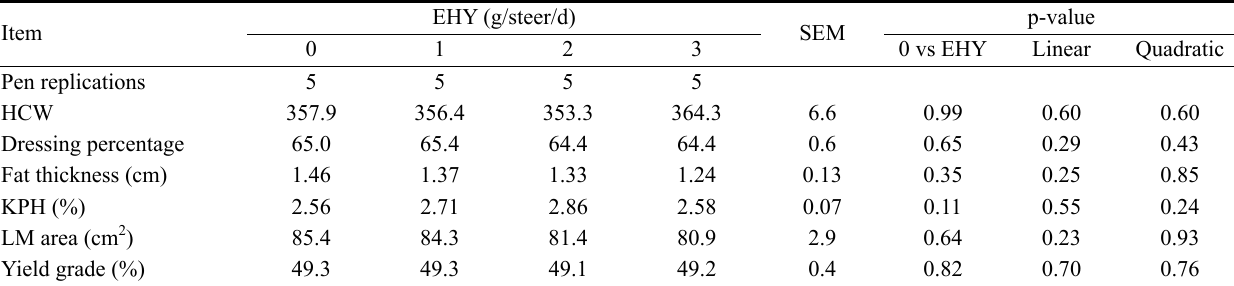
Table 3. Influence of enzymatically hydrolyzed yeast (EHY) supplementation on carcass characteristics of feedlot steers Item